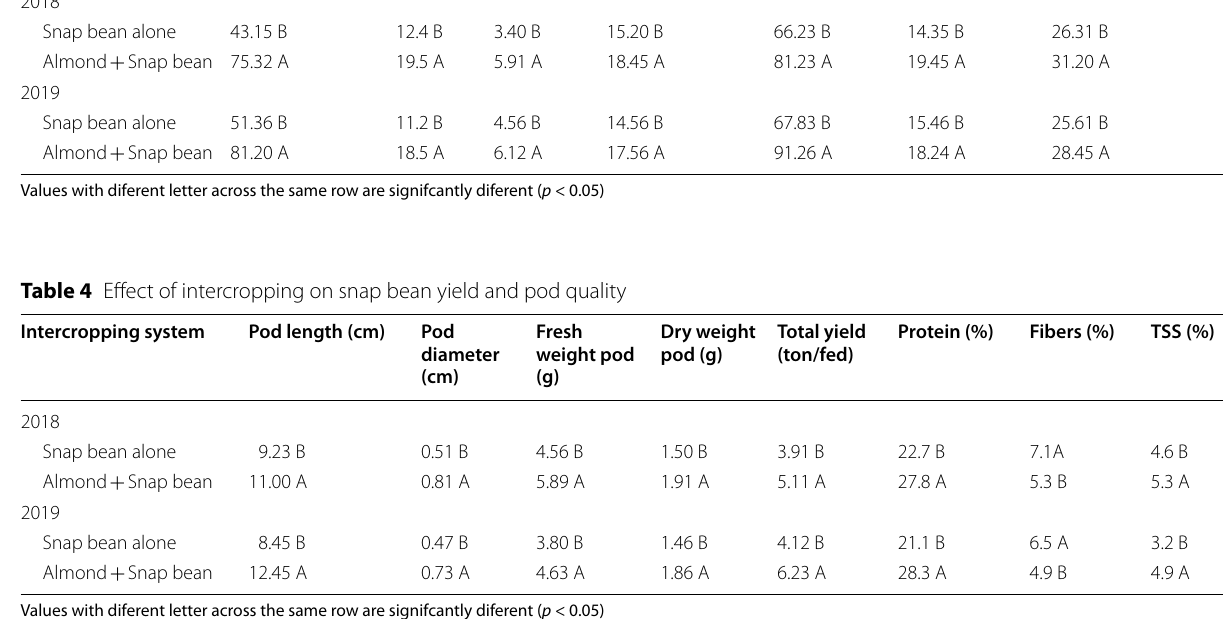
Values with diferent letter across the same row are signifcantly diferent ( p < 0.05)